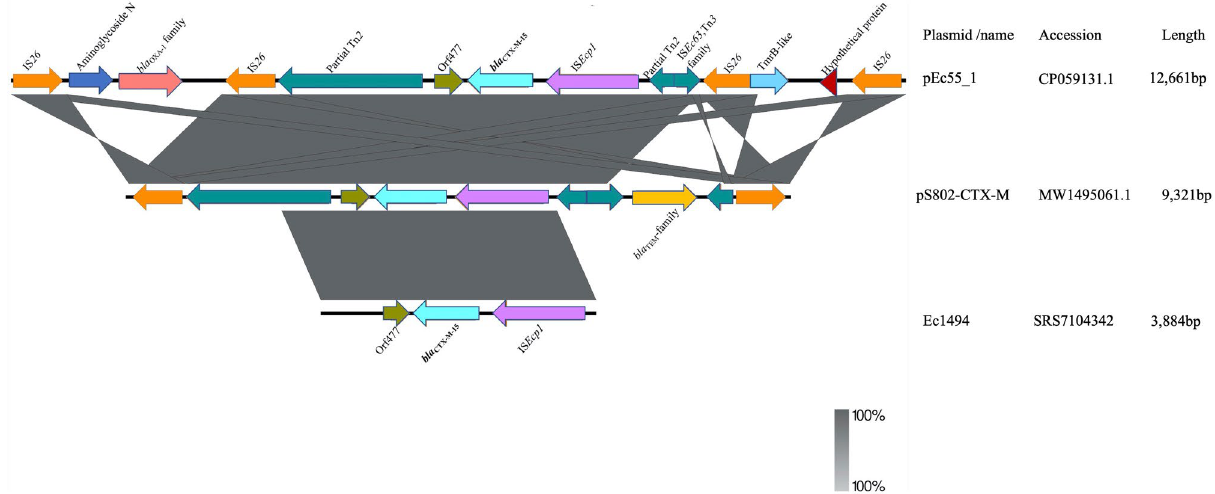
Figure 5. Comparison of the genetic environment of bla CTX-M-15 . Arrows depict the genes and sequences upstream and downstream of bla CTX-M-15 in their transcriptional directions as detected by sequencing. The structure of pS802-CTX-M was reversed to enable easy comparison. Shaded regions indicate regions that are common to all isolates. Figure was created and visualized with Easyfig v2.2.2 (https:// mjsull. github. io/ Easyfi g/ files.